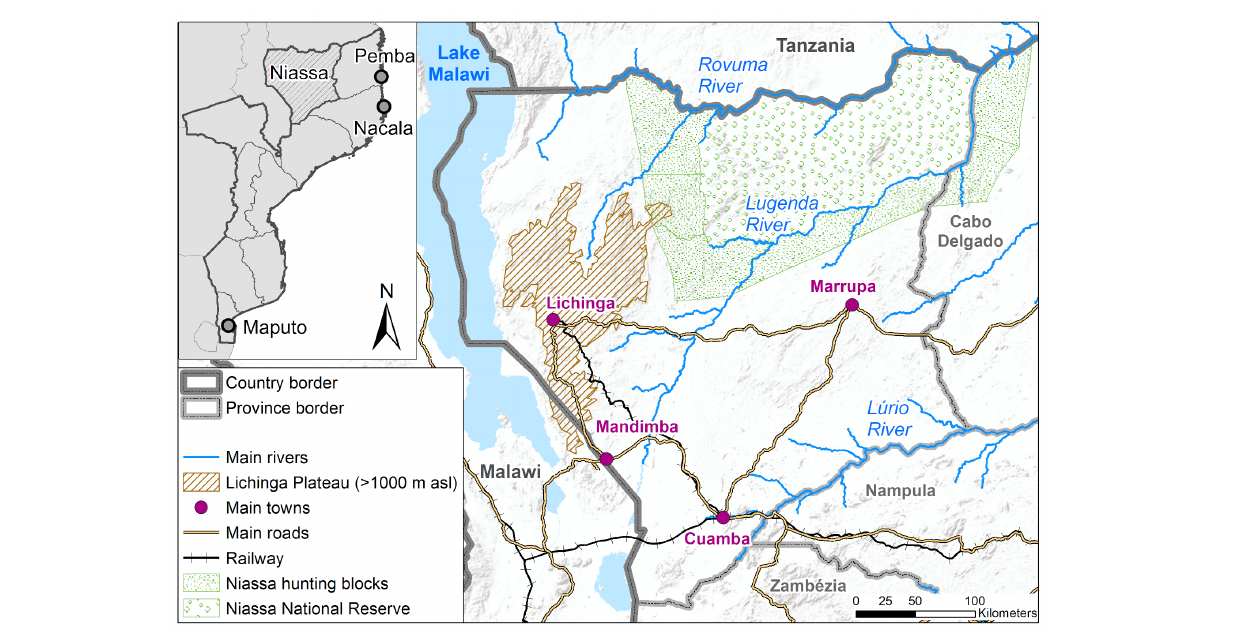
Fig. 1 . Niassa province,